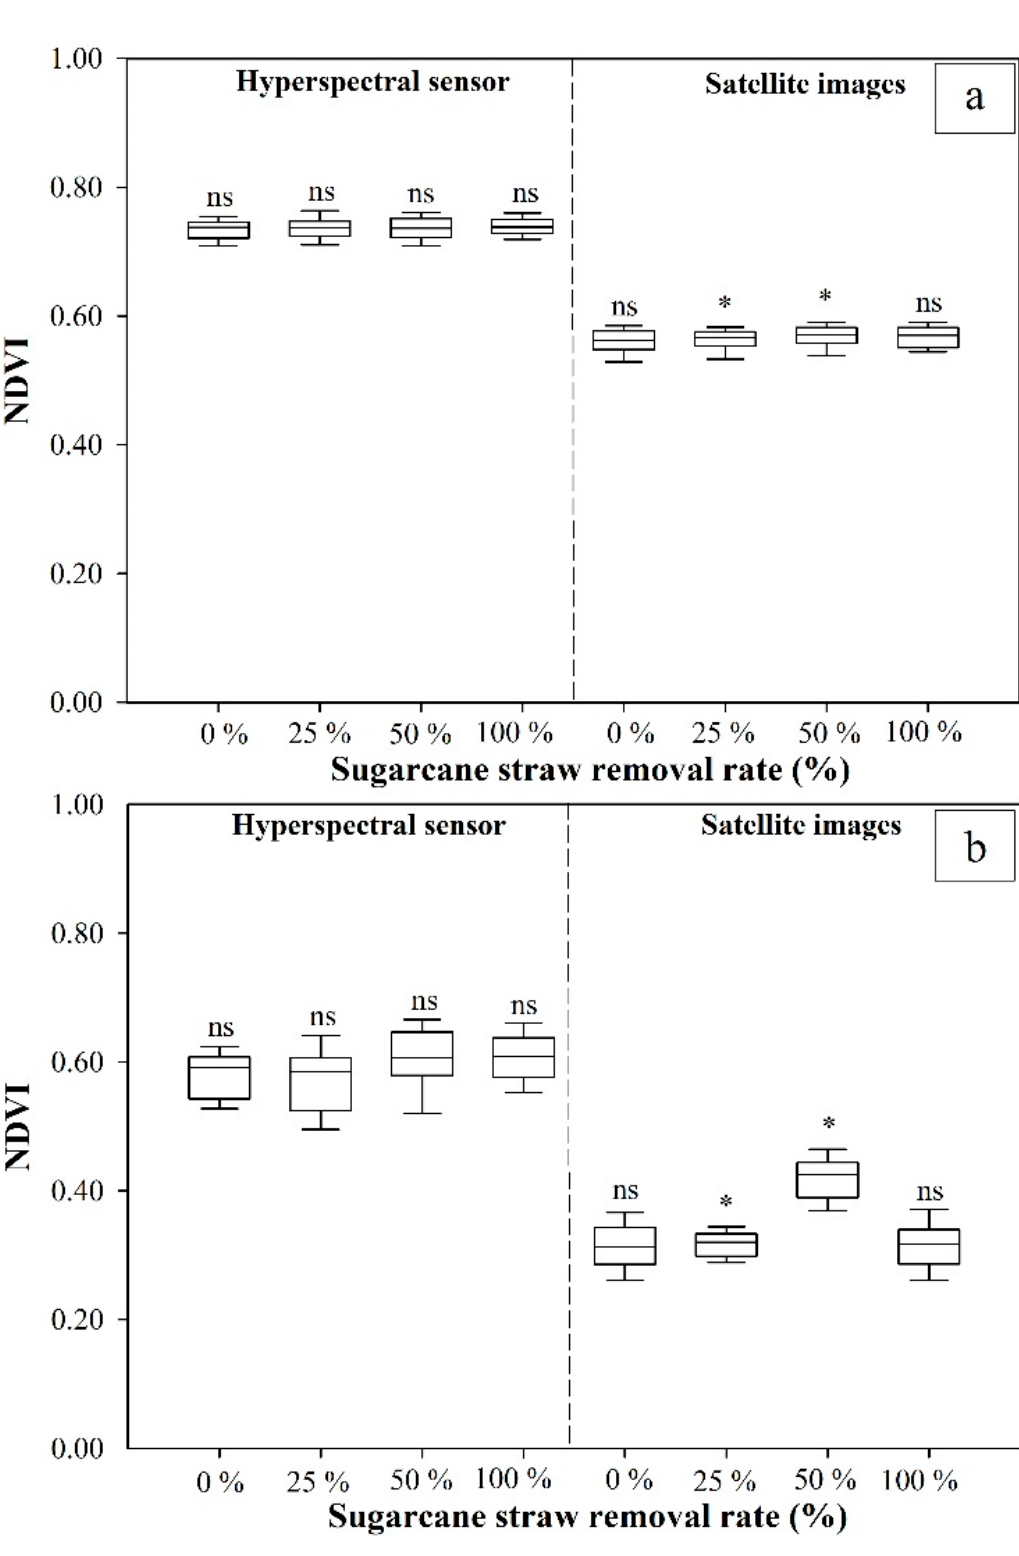
Figure 5. Values of NDVI for Areas 1 ( a ) and 2 ( b ) at the different rates of straw removal. Shapiro–Wilk Test for normal distribution, where: * significant ( p < 0.05) and ns not significant. When significant, it indicates that the hypothesis for normal distribution is rejected.